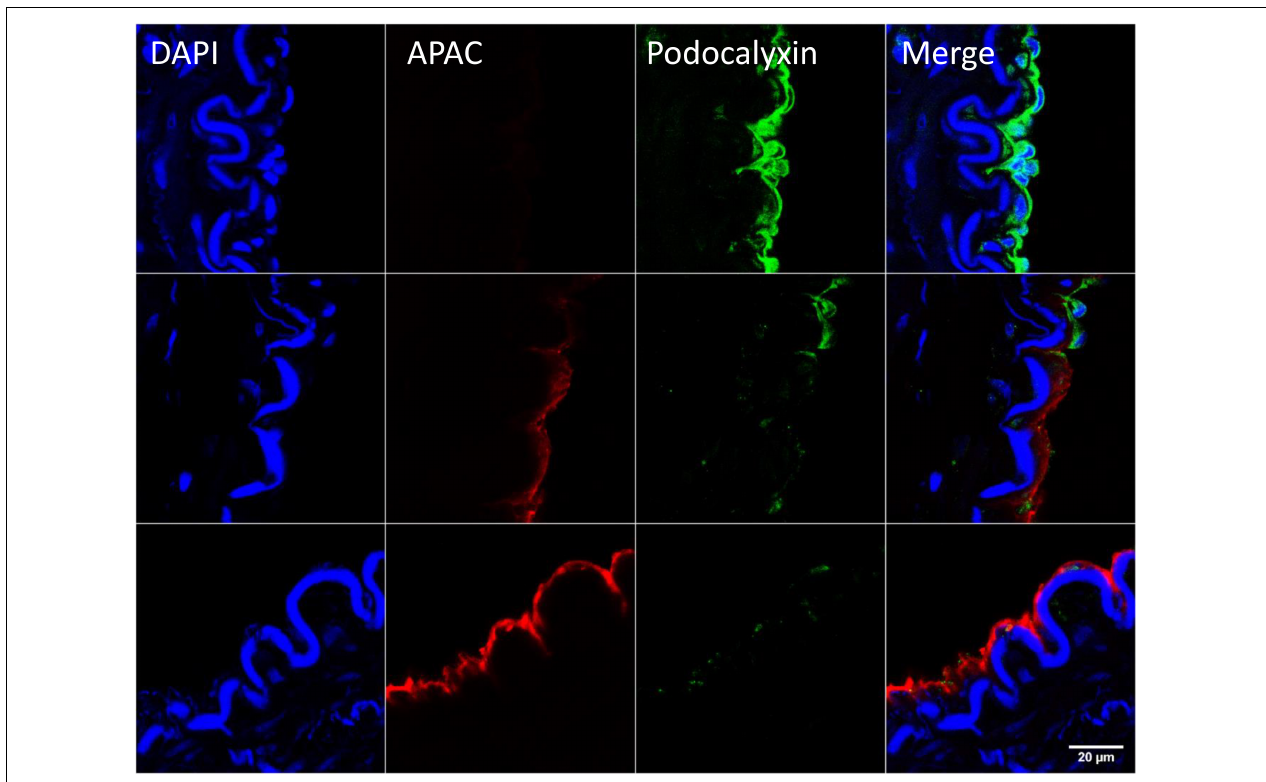
FIGURE 6 | Example of targeting and binding of the heparin proteoglycan mimetic, APAC at the injured arterial wall in vivo . APAC and podocalyxin double staining on the arterial injury of vascular anastomosis in pig (103). The anastomotic area was treated with biotinylated APAC (0.3 mg) before exposing to circulation. After 30 min of restored blood flow the artery was resected and processed for histology. Histological samples were stained for nuclei with 4 (cid:48) ,6-diamidino-2-phenylindole (DAPI) (blue), APAC (red), and podocalyxin (green). Podocalyxin is a glycosylated cell surface sialomucin expressed, e.g., by vascular endothelial cells and hematopoietic progenitors (107). Disrupted endothelium is depicted by the binding of APAC and the intact endothelium by the binding of podocalyxin. APAC signal was absent at the sites of podocalyxin (merge). Scale bar corresponds to 20 µ